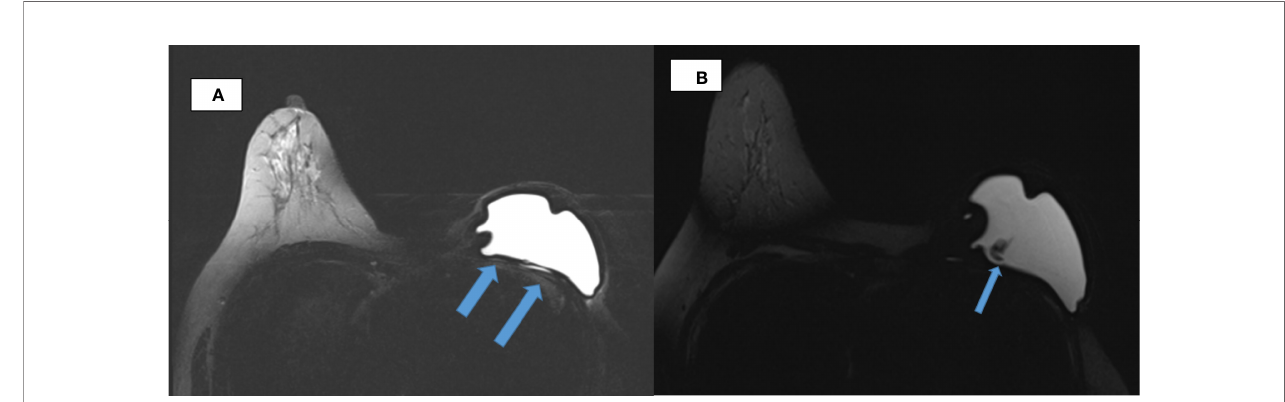
FIGURE 1 | Breast MRI. (A) Axial TIRM image of MR breasts demonstrates irregularity of the silicone implant shell with inward invagination in the left breast. Linear hyperintensity that is of fl uid intensity noted posterior to the implant till its lateral border raises the suspicion of an extracapsular rupture (arrowed). (B) Wavy lines (arrowed) evident within the silicone implant giving the linguine sign, which suggest an intracapsular rupture.